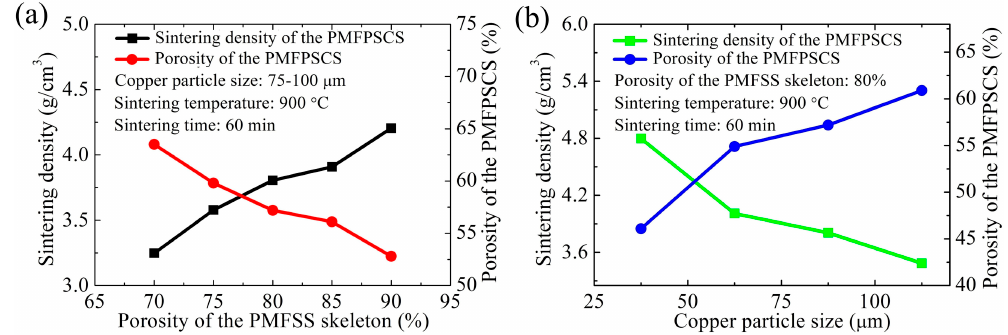
Figure 2. Sintering density and porosity of the PMFPSCS versus different structure parameters sintered at 900 °C for 60 min: ( a ) different porosities of the PMFSS skeleton; and ( b ) different copper particle sizes.